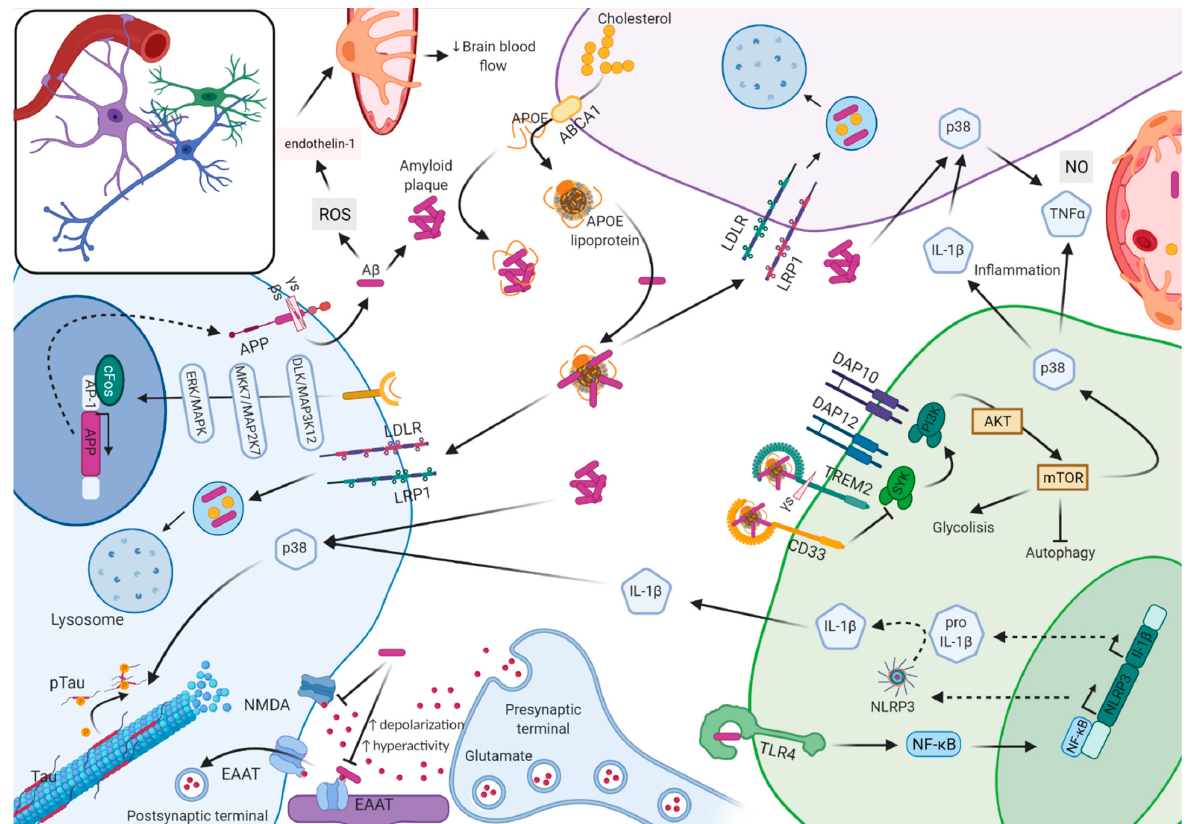
Figure 1. Schematic representation of the molecular interplay between neurons, astrocytes, microglia, and vasculature system in Alzheimer’s disease. Neurons produce the transmembrane amyloid precursor protein (APP). APP is cleaved by γ ( γ s) and β secretase ( β s) into amyloid β (A β ) units of different length aggregates extracellularly into plaques. Oligomeric A β promotes the generation of ROS that triggers the release of endothelin-1, causing perycite constriction, which decreases brain blood flow. Soluble A β blocks the reuptake of synaptically released glutamate by either N-methyl-D-aspartate receptor (NMDA) or by excitatory amino acid transporter (EAAT) receptors causing glutamate accumulation perisynaptically (excitotoxicity), which increases depolarization and promotes hyperactivity. In microglia, A β binds to the toll-like receptor 4 (TLR4), which causes translocation of the nuclear factor kappa-light-chain-enhancer of activated B cells (NF- κ B) from the cytosol to the nucleus, where it increases the transcription of NLRP3 and pro-IL-1 β . In the cytoplasm, via activated caspase-1, the inflammasome promotes the maturation of IL-1 β . Amyloid plaques stimulate the activation of p38MAPK (p38) in microglia, astrocyte, and neuron. In microglia, p38 activation results in upregulation of proinflammatory cytokines, interleukin 1 β (IL-1 β ) and tumor necrosis factor α (TNF α ); IL-1 β in turns activates p38 in astrocytes and neurons. In astrocytes, p38 activation causes increased expression of TNF α and nitric oxide (NO) and excitotoxicity. In neurons, p38 activation results in tau phosphorylation (Tau → p-Tau) and microtubule disassembly. APOE is mostly generated by astrocytes; free APOE can facilitate A β blood bran barrier (BBB) transit, but it can also accelerate aggregation and deposition of A β in an isoform-dependent manner. APOE can be lipidated by ABCA1 transporter-forming lipoprotein particles that bind soluble A β , which are then uptaken by neurons and glia via cell-surface receptors, including low-density lipoprotein receptor (LDLR) and low-density lipoprotein receptor-related protein (LRP1), and degraded at the lysosome. When free APOE binds to ApoE receptors in neurons, it can activate a non-canonical MAPK pathway, in an isoform-dependent manner, that induces cFOS phosphorylation stimulating the transcription factor AP-1, which in turn enhances transcription of APP. The complex amyloid plaque lipidated APOE can stimulate microglia through transmembrane proteins triggering receptor expressed on myeloid cells 2 (TREM2) and sialic acid-binding Ig-like lectin 3 (CD33). TREM2 activation induces the association of TREM2 to DAP12, which gets phosphorylated and recruits spleen tyrosine kinase (SYK), which activates phosphoinositide 3-kinase (PI3K) that depends on DAP10. PI3K targets protein kinase B (AKT) and activates the mammalian target of rapamycin (mTOR), which activates glycolysis, the p38MAPK pathway, and inhibits autophagy. Instead, CD33 activation inhibits PI3K. The complement receptor 1 (CR1) is a receptor for the complement components C3b and C4b and promotes the phagocytosis of A β